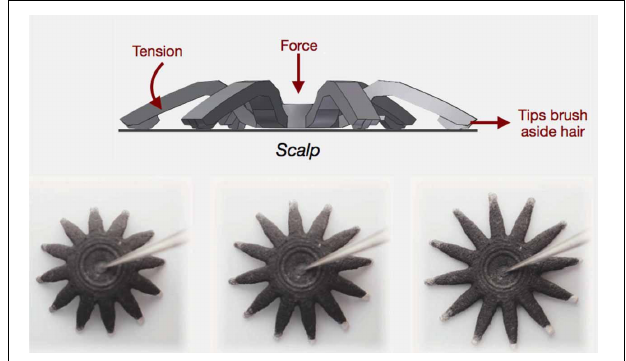
FIGURE 1 | Schematic of Cognionics active dry Flex sensor. Top: deformation of the sensor brushing hair aside. Bottom: Top view of the sensor spreading over a surface. The sensor has 15.24mm in diameter and 11.43mm in height. Picture courtesy of Cognionics. (Cognionics, Inc., San Diego, CA